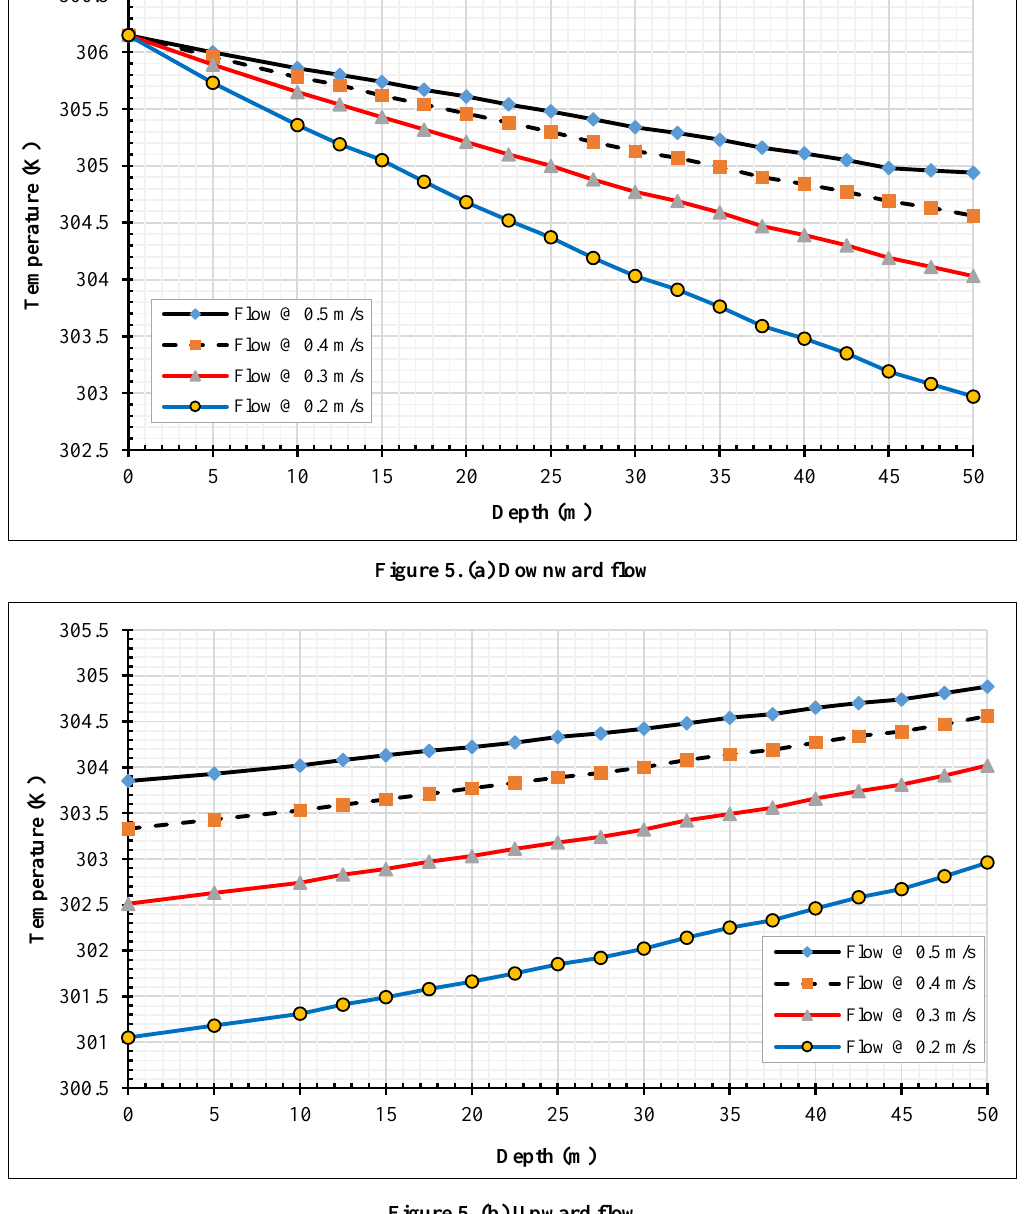
Figure 5. (b) Upward flow Figure 5. Water temperature distribution comparison at different flow velocities for the single